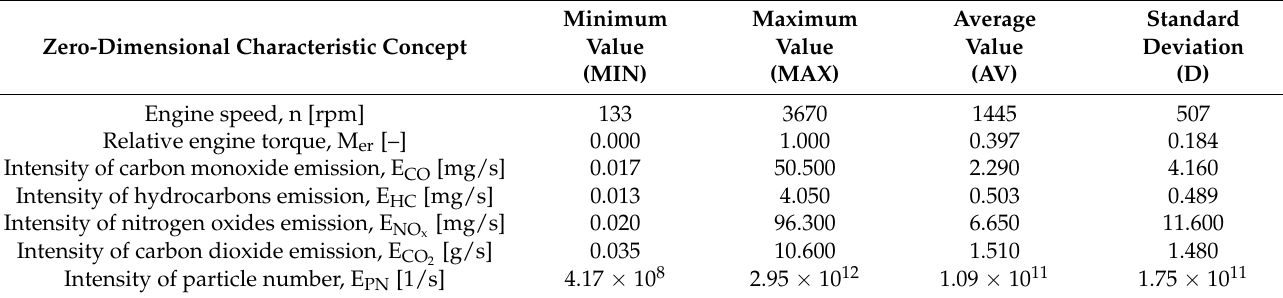
Table 2. The zero-dimensional characteristics of the engine speed processes, relative torque and processes of exhaust emission intensity (the minimum value, the maximum value, the average value, and the standard deviation).